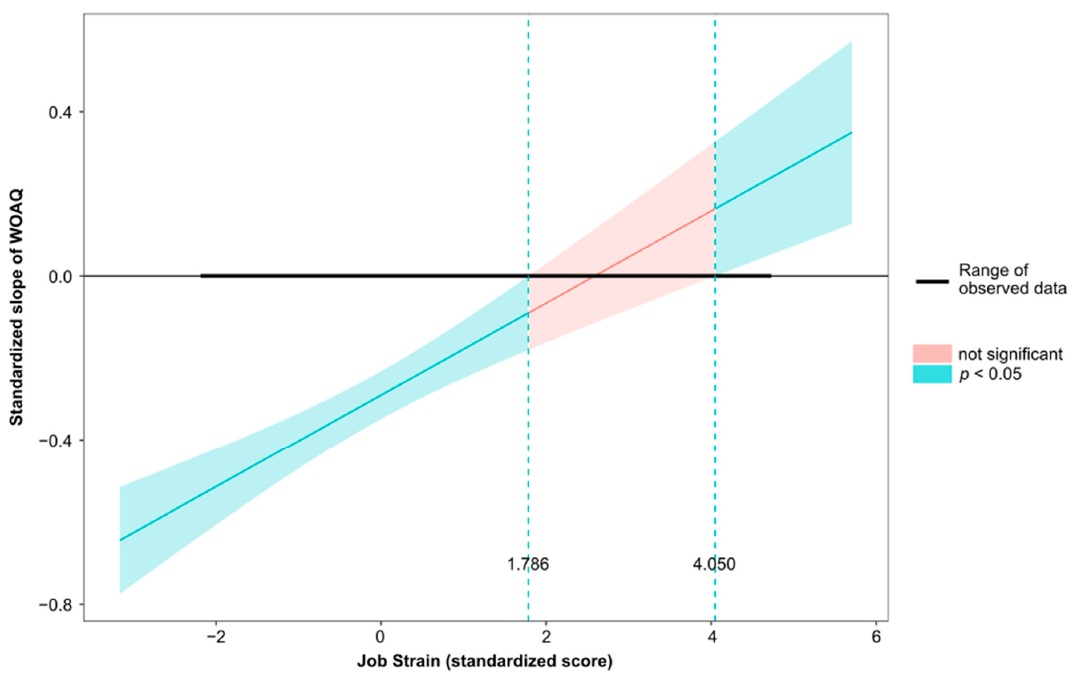
Figure 4. Simple slopes plot for the ERI model.